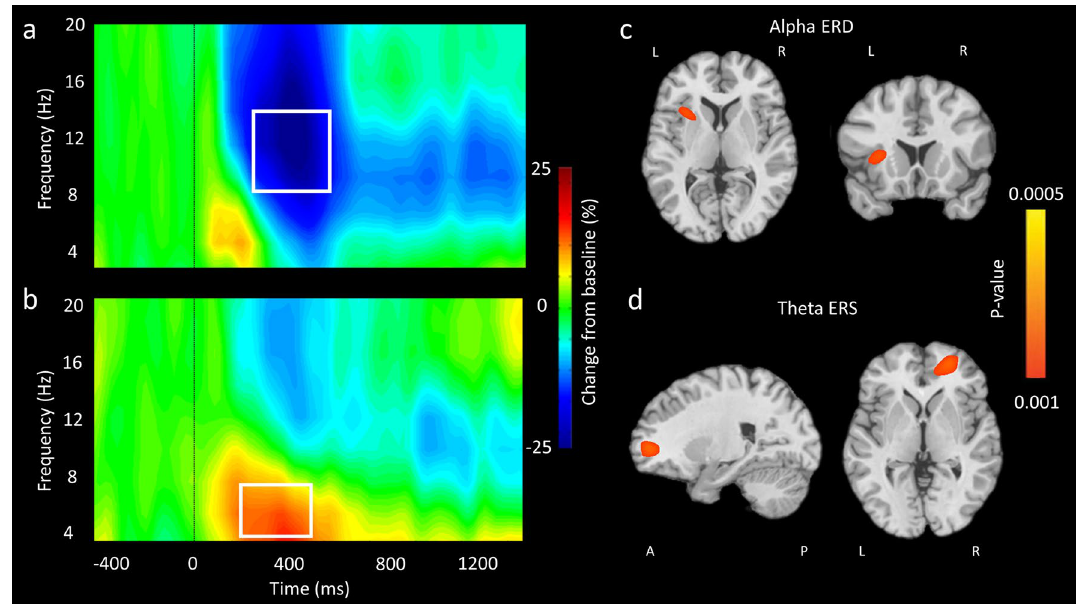
Figure 3. MEG sensor-level activity and whole brain repeated-measures ANOVA results for alpha ERD and theta ERS responses. MEG sensor-level grand-averaged spectrograms for the alpha ERD response in a sensor located over the parietal cortex ( a ), and the theta ERS response in a sensor located over the frontal cortex ( b ). In each, time (ms) is represented on the x-axis with 0 ms indicating stimulus onset (i.e., when arrows appeared). Relative spectral power is expressed as a percentage difference from baseline, with the color legend shown to the right of the spectrograms. As shown, there was a prominent alpha ERD (8–14 Hz) that began about 250 ms after stimulus onset and lasted until 650 ms. Additionally, there was a theta ERS (4–8 Hz) that began 200 ms after stimulus onset and was sustained until 600 ms. Whole-brain repeated-measures ANOVAs (condition x group) revealed an interaction for the alpha oscillations (8–14 Hz) in the left insula ( c ), while the same analysis for theta oscillations (4–8 Hz) showed an effect in the right middle frontal gyrus ( d ). All source images were created using NeuroElf V1.1(https ://neuro